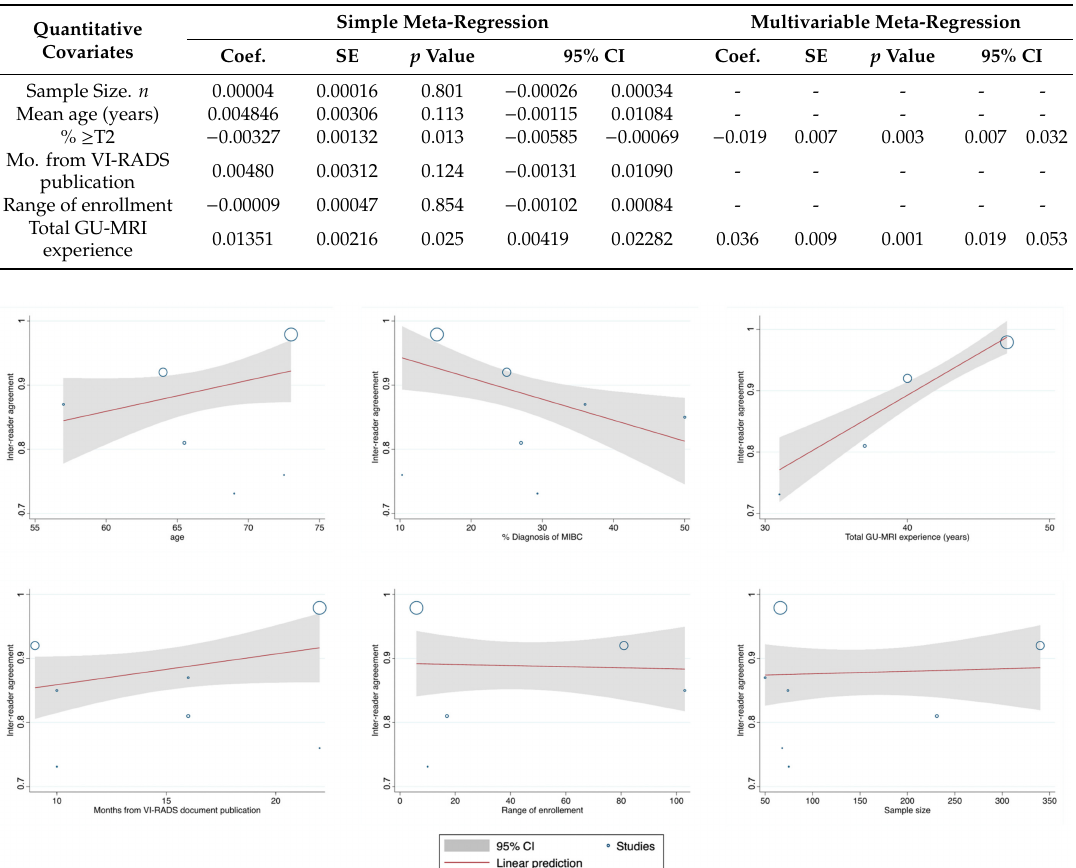
Figure 4. Meta-regression plots of the quantitative variables retrieved among the studies included in the